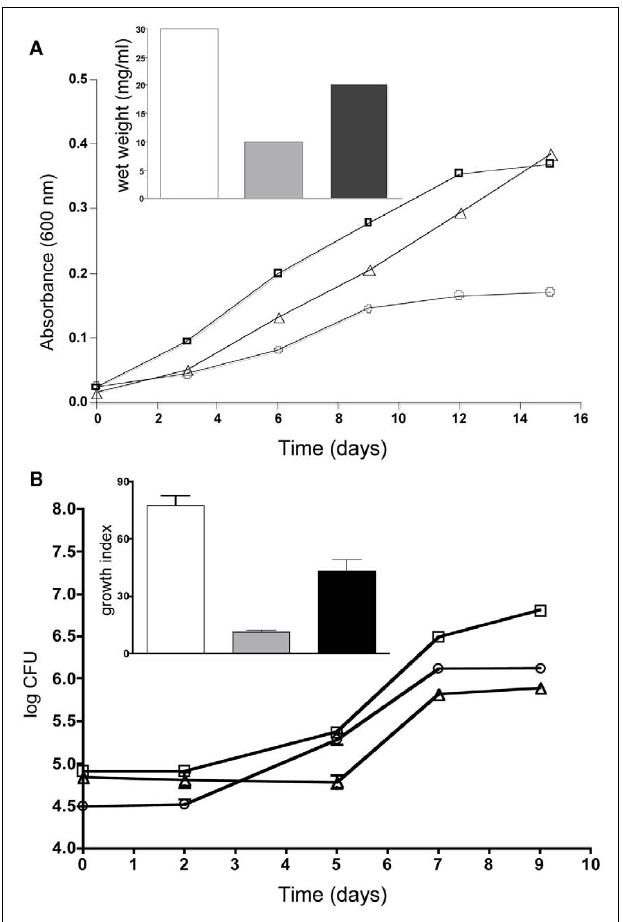
FIGURE 6 | esxJIi mutation reduces growth in cultures. (A) Cultures were grown in 7H9 broth supplemented with 0.05%Tween and OADC and optical density measurements taken at 600nm. Growth of wild-type is indicated with squares, esxJIi mutant with circles, and esxI complemented strain with triangles.The inset shows wet weight measurements of wild-type (bar), esxJIi (gray bar), and esxI complemented strain (black bar) at 15days of growth. A representative of three independent experiments is shown. (B) Co-culturing with wild-type bacteria rescues growth of esxJIi mutant. Growth of H37Rv (squares), the esxJIi mutant (triangles), and the esxJIi mutant in co-culture (closed circles) were determined by enumerating CFUs. Plate counts were in triplicate and averaged. Inset shows growth indices for wild-type (bar), esxJIi mutant (gray bar), and esxJIi mutant in co-culture (black bar) calculated as CFU at 9days relative day 0. Data shown is a representative of three independent experiments where the wild-type and mutant were grown both independently and in co-culture, and showed this difference in growth of the mutant.